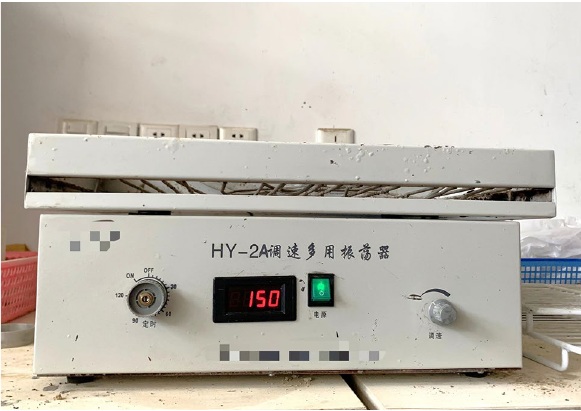
Figure 2. The HY-2A speed governing